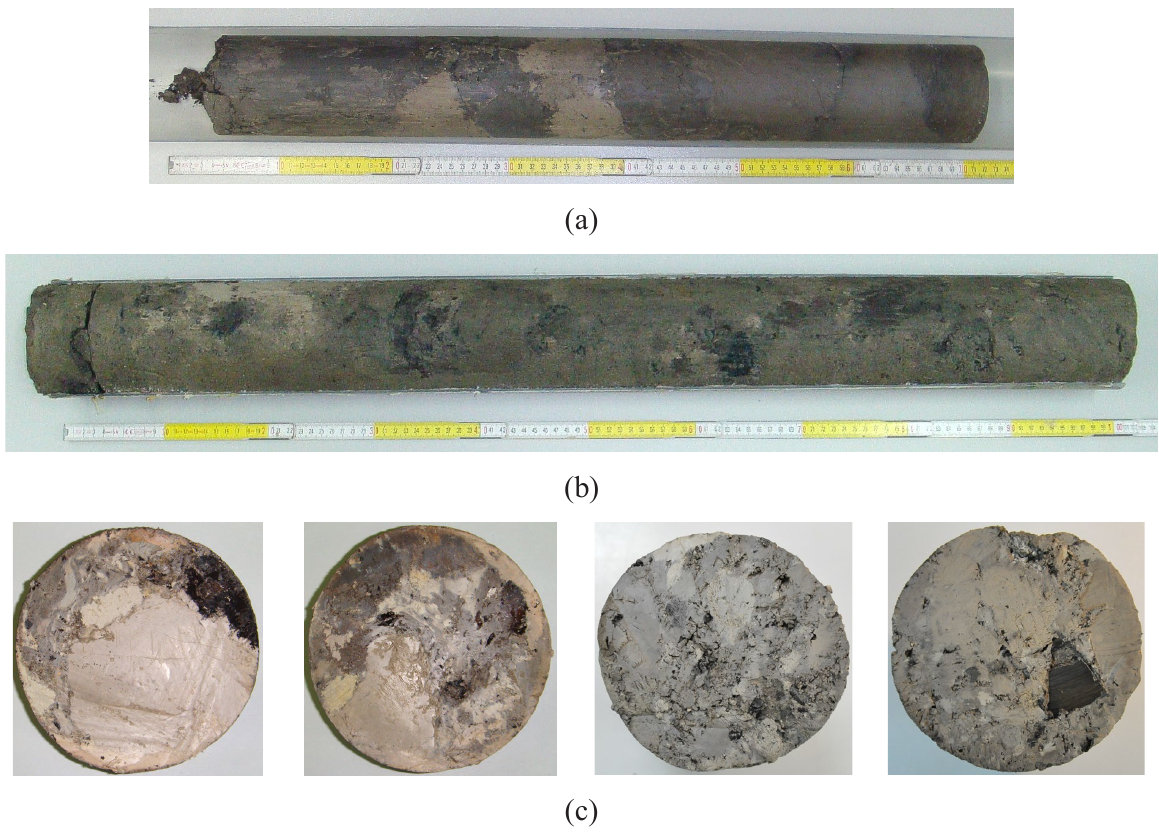
Fig. 1. View of the dump soil samples: Figure 1: View of the dump soil samples: (a) after extracting from Shelby tube